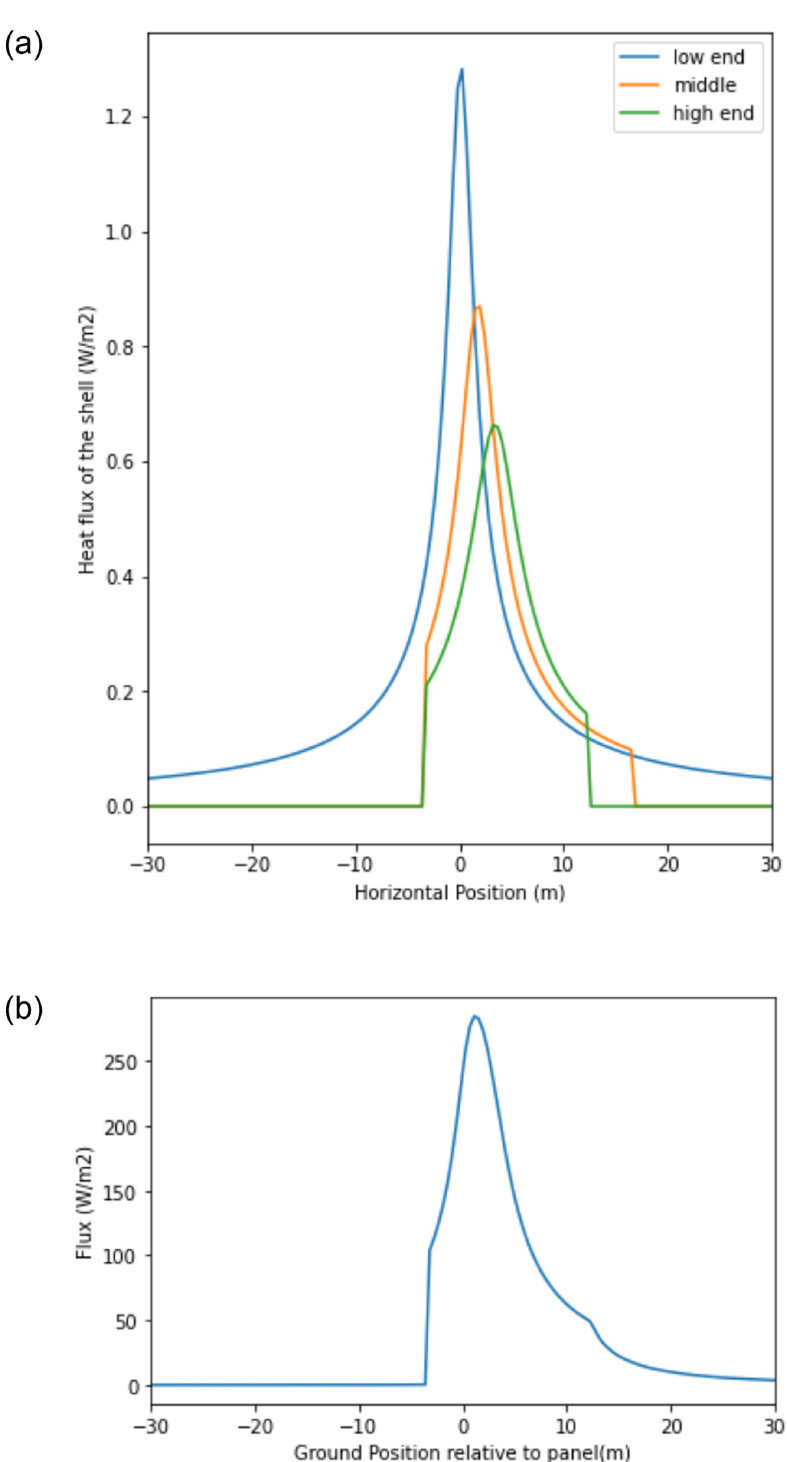
Fig 3. a. Heat flux resulting from three different panel elements. b. Heat flux from one single panel, for arbitrary panel temp T P = 300 K, where x = 0 occurs at lower edge of